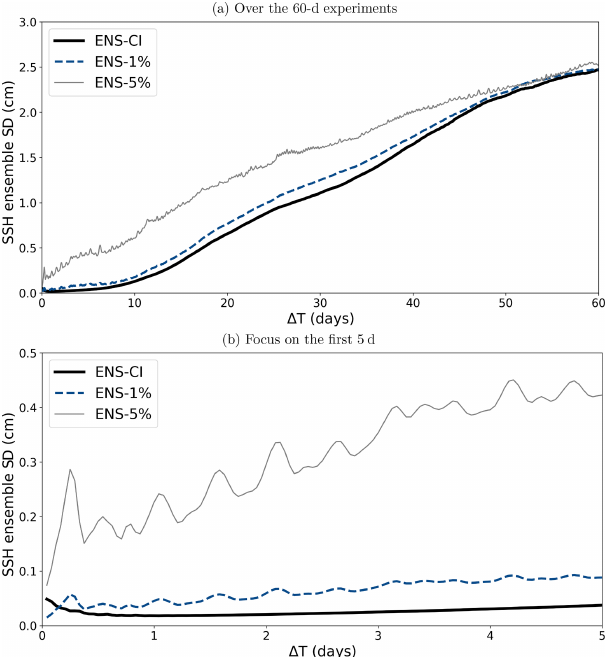
Figure 5. Time evolution of the ensemble standard deviation of the hourly SSH, then spatially averaged over the entire MEDWEST60 domain for the three ensemble experiments (ENS-1%, ENS-5%, ENS-1%-S, ENS-CI): (a) over 60d; (b) focus on the first 5d of